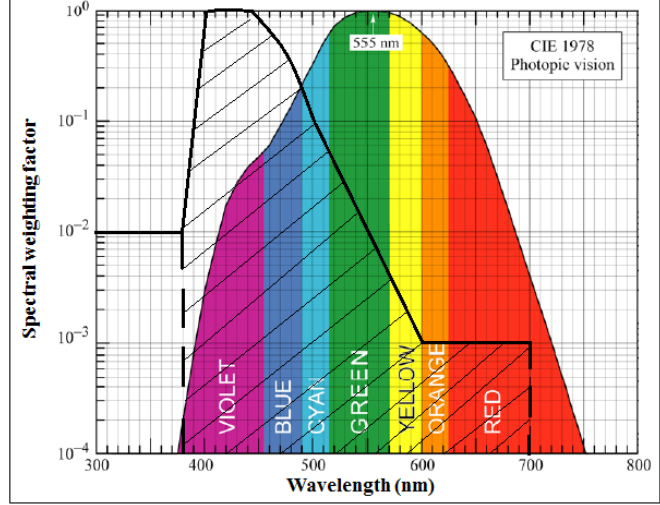
, having overlap with photopic function, V (λ)